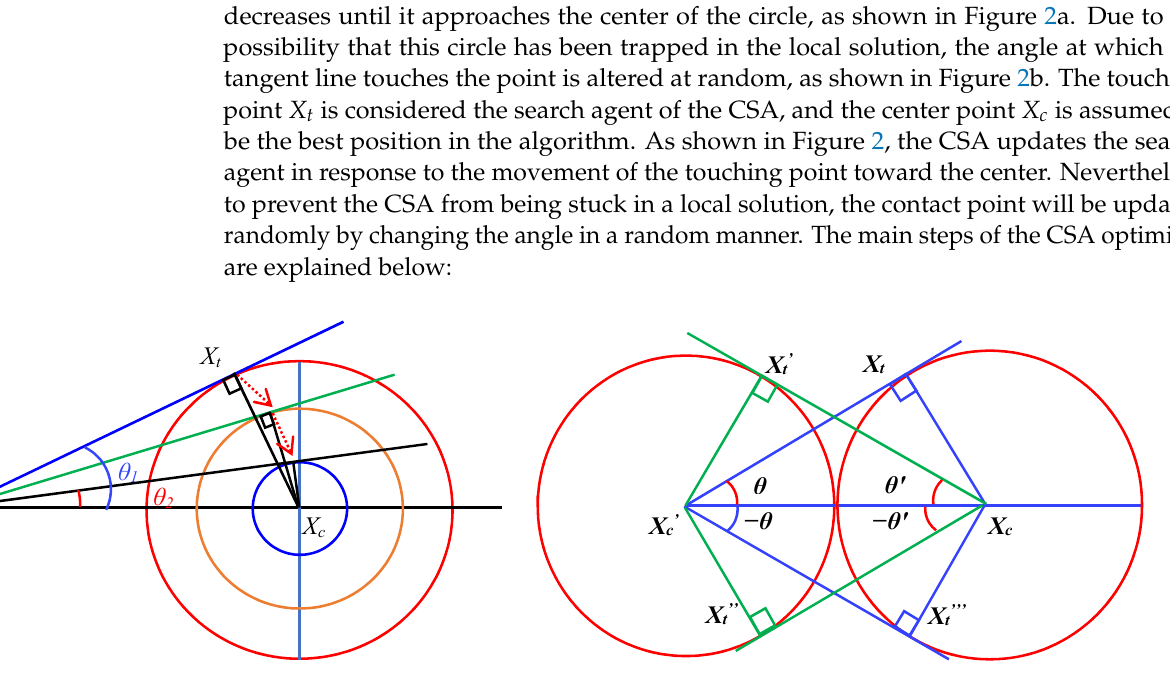
Figure 1. Terminologies of the geometric circle.